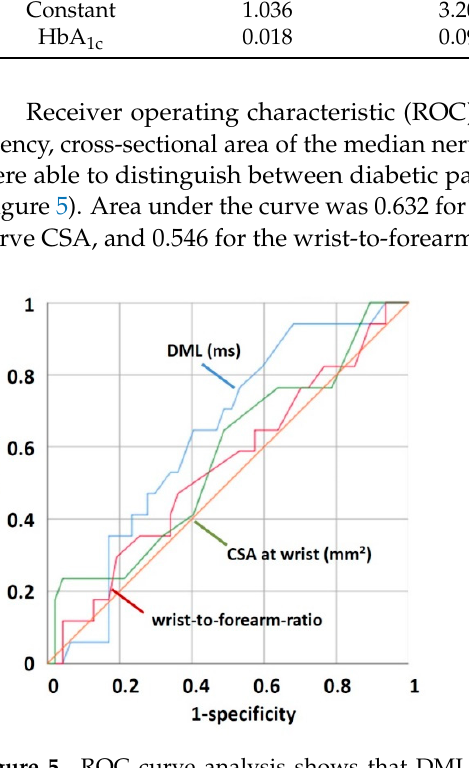
Figure 5. ROC curve analysis shows that DML, median nerve CSA at the wrist, and wrist-to- forearm-ratio were not suited to distinguish between diabetic patients with and without symptoms for